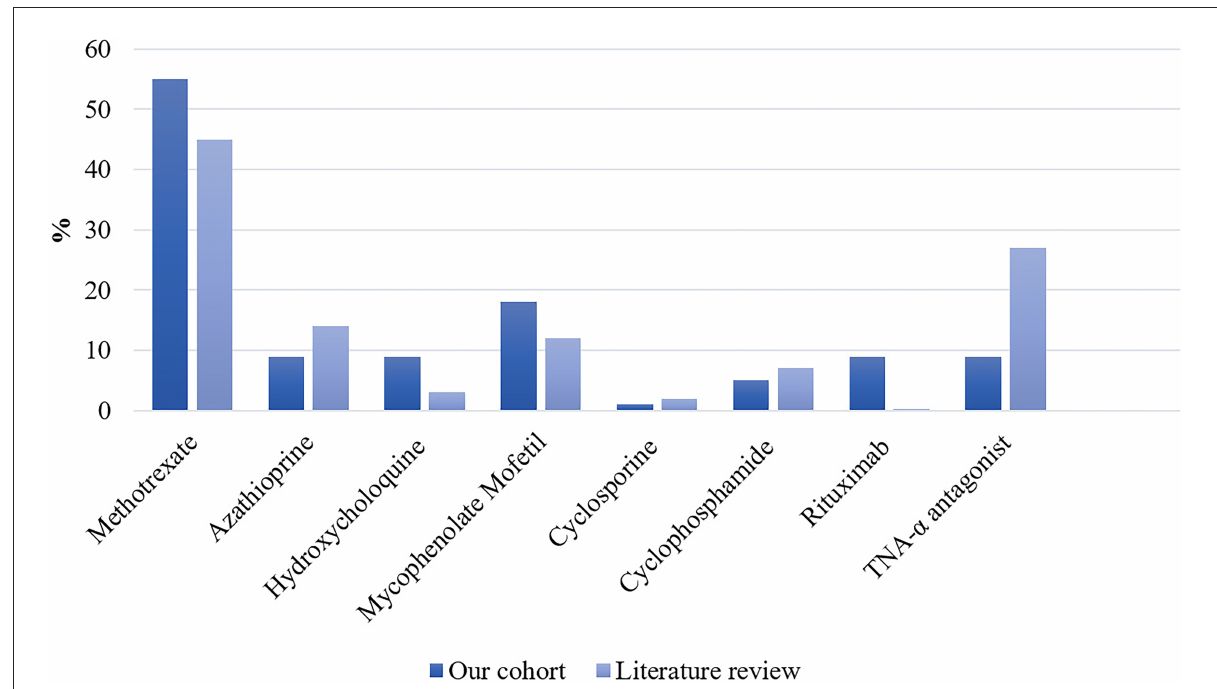
FIGURE4 Proportion of second- and third-line therapies in our patient cohort ( n = 22) and the literature expressed as percentages. In the literature: n/N = 557/1,248 for methotrexate; n/N = 185/1,363 for azathioprine; n/N = 44/1,431 for hydroxychloroquine; n/N = 178/1,431 for mycophenolate mofetil; n/N = 20/1,425 for cyclosporine; n/N = 99/1,431 for cyclophosphamide; n/N = 5/1,431 for Rituximab; and n/N = 405/1,494 for TNF- α antagonist.